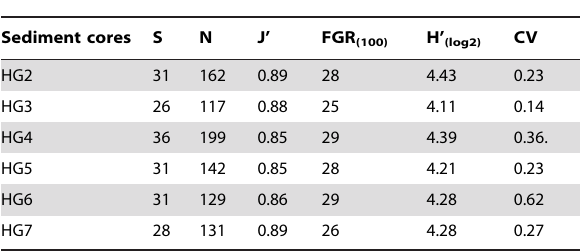
Table 5. Univariate diversity measures and coefficient of variation for the ecological life-form types of control and sponge cores (0–1 cm sediment depth).